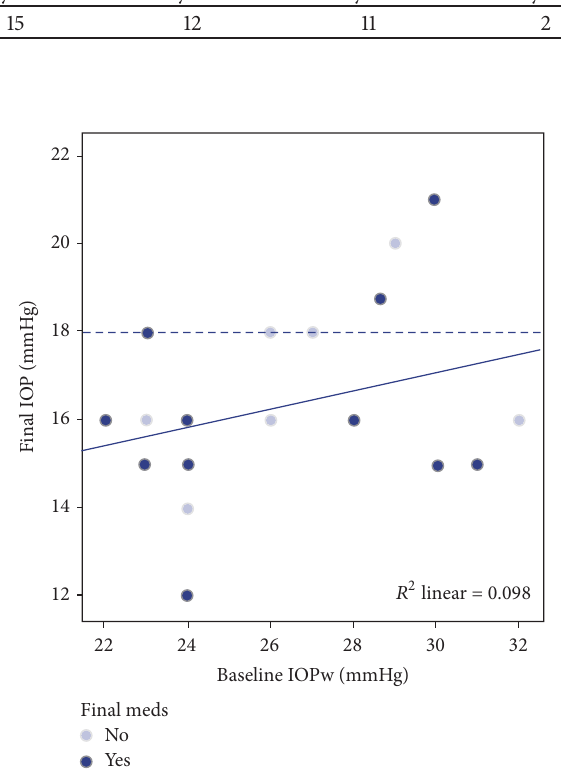
Figure 2: Scatter plot representing preoperative intraocular pres- sure (IOP) after washout and postoperative IOP without and with meds. Continuous line represents regression line ( R 2 = 0.098). Discontinuous line represents IOP of 18mmHg, defined as success in the study.